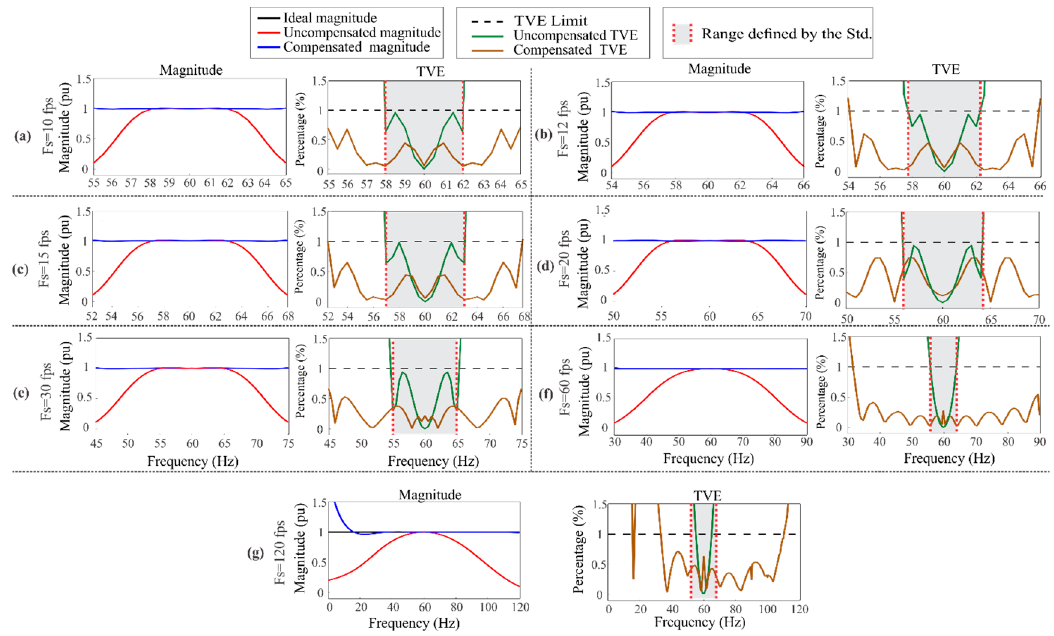
Figure 5. Magnitude and total vector error (TVE) results for steady-state test: ( a ) 10 fps, ( b ) 12 fps, ( c ) 15 fps, ( d ) 20 fps, ( e ) 30 fps, ( f ) 60 fps and ( g ) 120 fps.